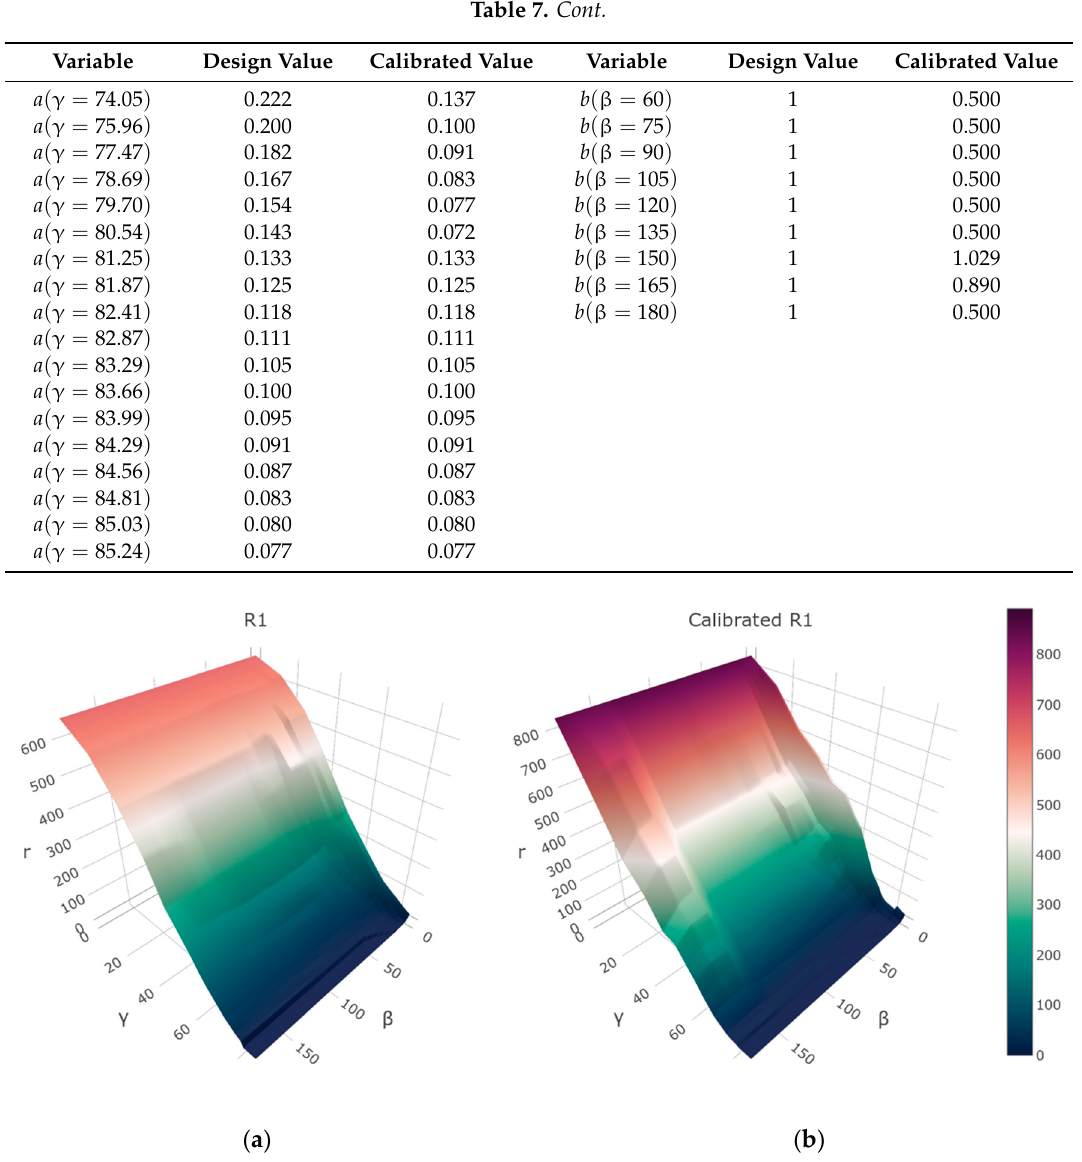
Figure 11 . Depiction of the r-table for the standard R1 road surface ( a ) and the calibrated surface ( b ).